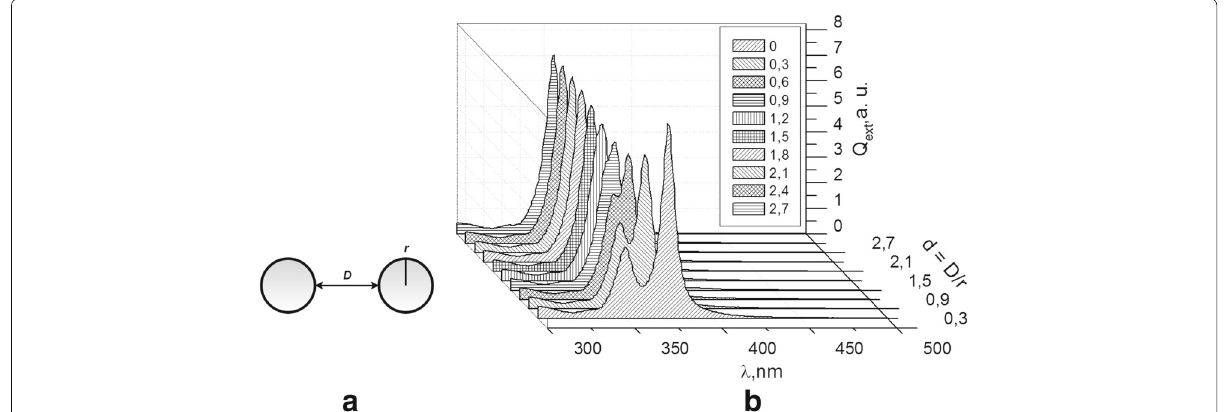
Fig. 1 a The dimer with nanoparticle radius r and interparticle distance D . b The effective extinction spectra of nanoparticle dimer dependent on the interparticle separation